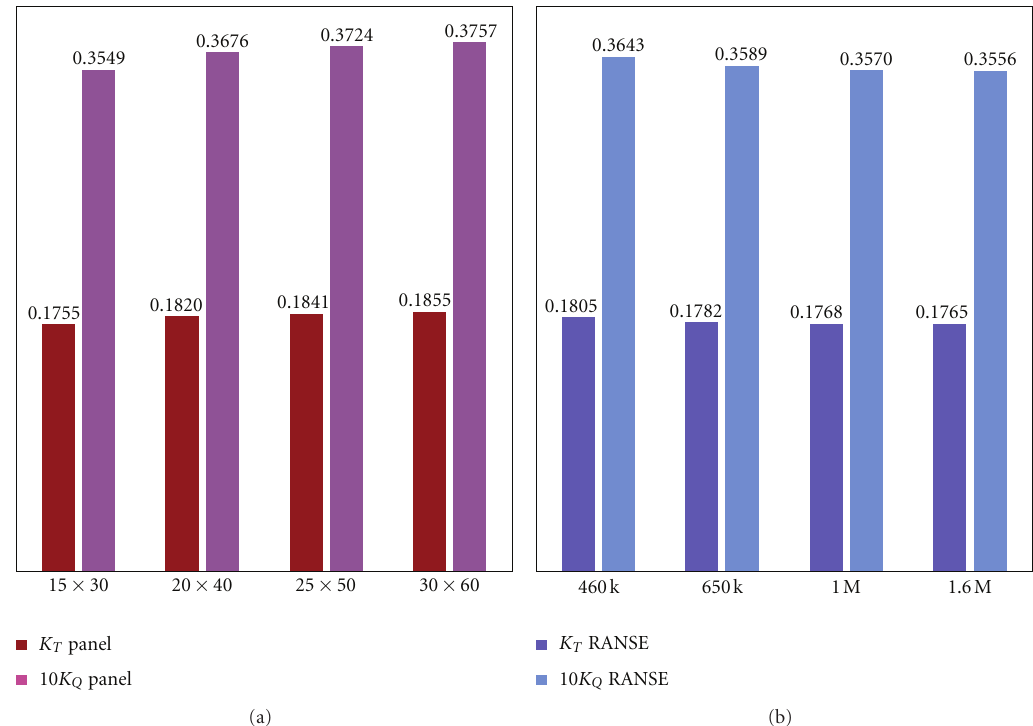
Figure 6: Convergence of open water thrust and torque coe ffi cient with the number of panels and the number of cells for the potential and the RANSE solution.